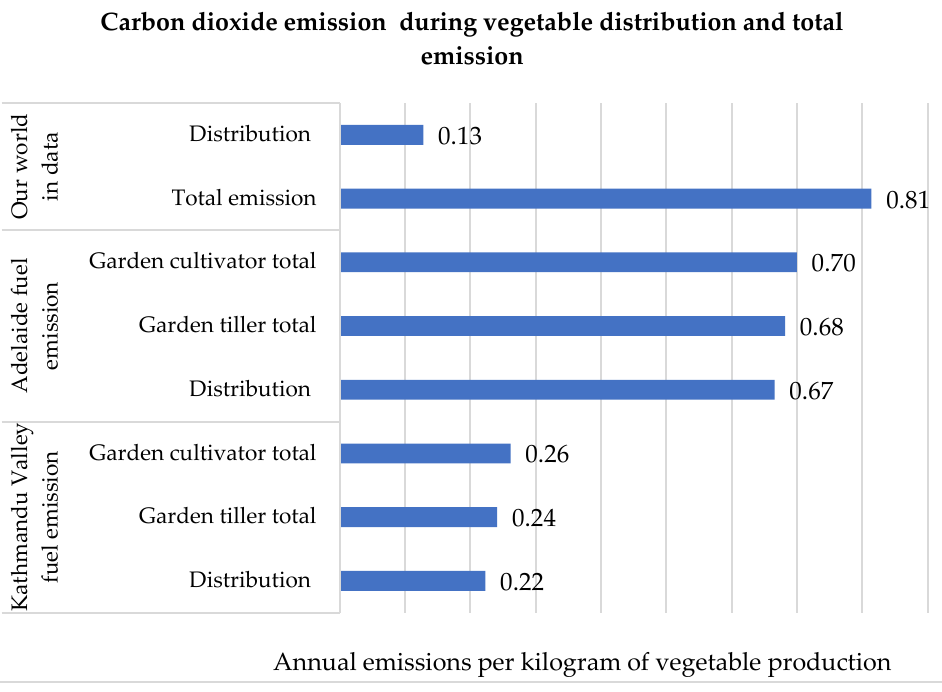
Figure 11. Comparison of total and distribution emissions from fuel use with available data.